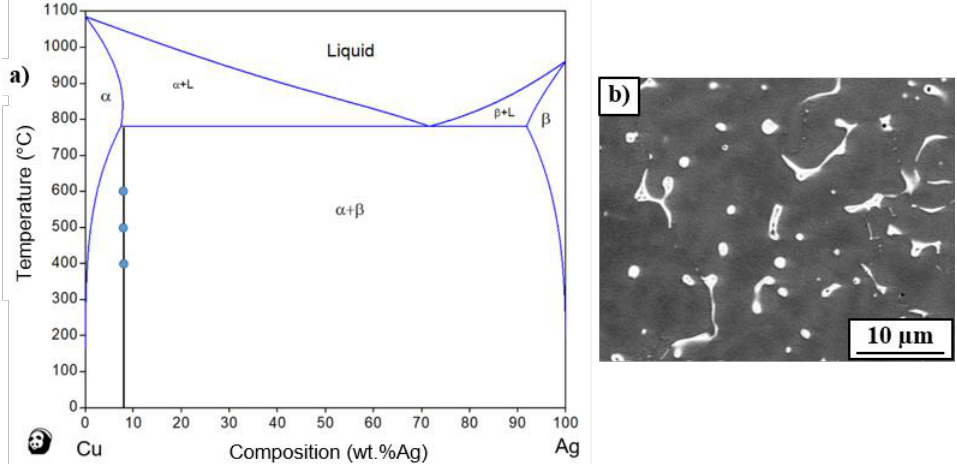
Figure 1. ( a ) phase diagram of Cu–Ag system [20] with vertical line showing chemical composition of the examined alloys, while dots show annealing temperatures of examined samples; ( b ) SEM image of the as-cast Cu–8wt.%Ag alloy.